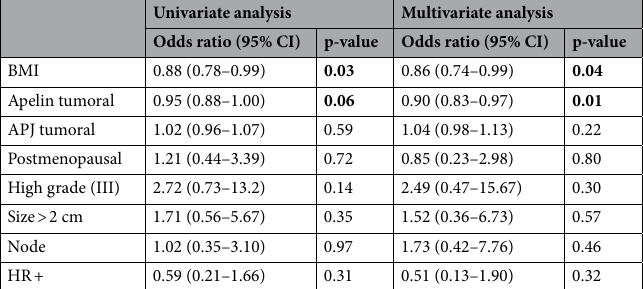
Univariate analysis Multivariate analysis